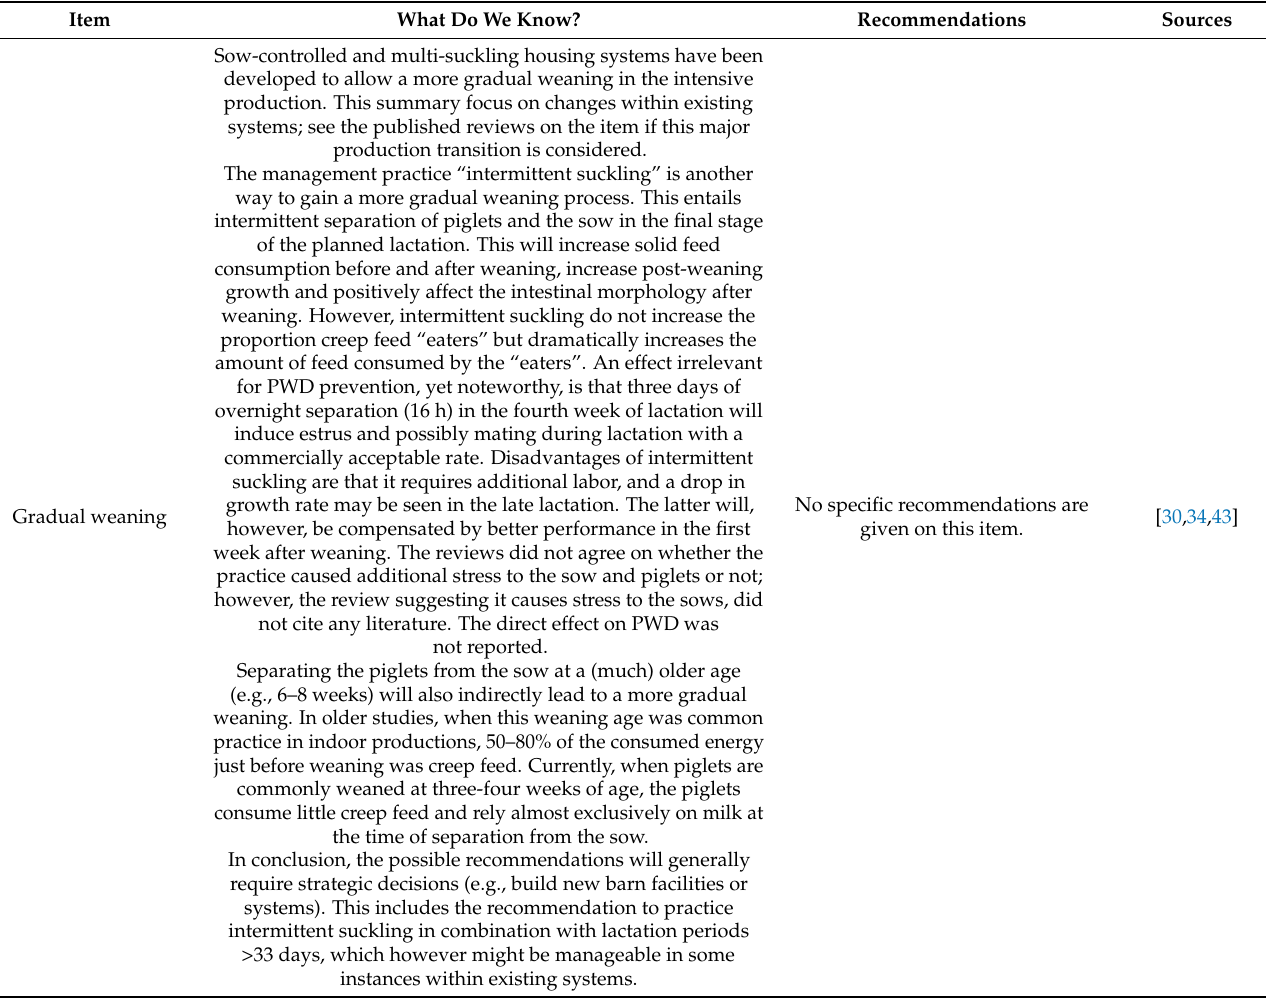
Table 3. Management during